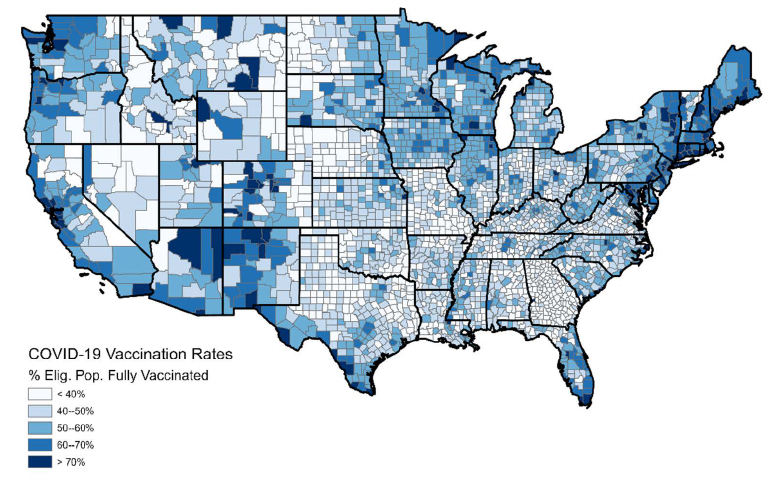
Figure 1. County–by–county vaccination rates for 1 January 2022